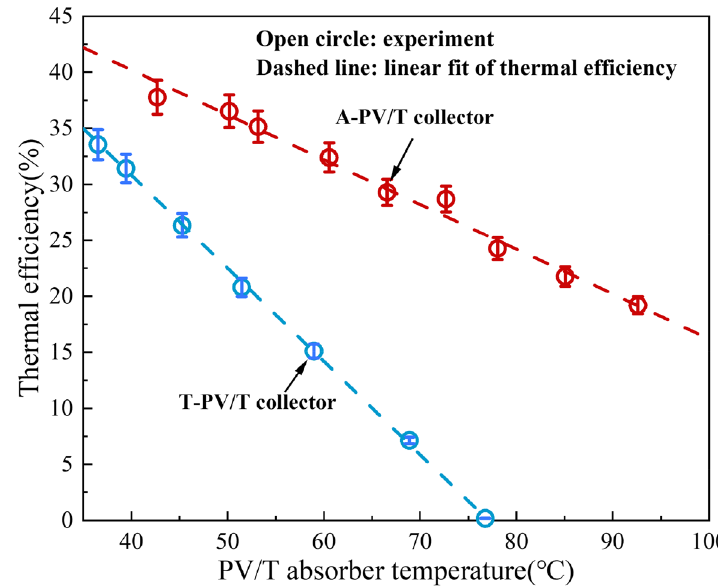
Fig. 9 Measured and fitted thermal efficiency of the A-PV/T and the